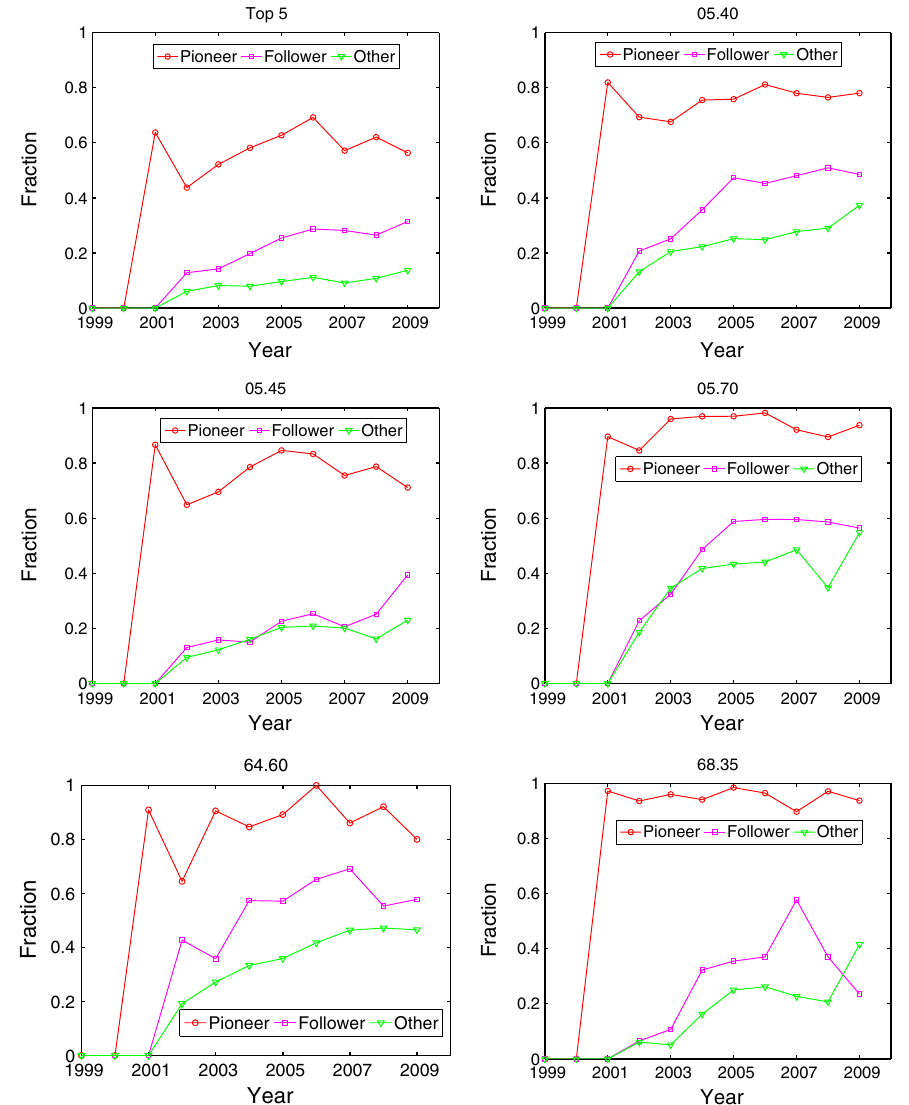
FIG. 6. Comparison of the fraction of papers published by pioneers, followers, and followers of followers. Followers are the scientists who cited at least one paper of the pioneers between 1997 and 2001 and are not the cooperators of pioneers. For a given PACS number, as indicated in the figures, we record the number of papers published in the PACS number and the number of papers published only in 89.75 ( “ Complex Networks ” ) for each author. Then, we get the total number of papers published in complex networks N number of papers with these two PACS numbers N for every author. The vertical axis shows the fraction ð N all time, which approximately satisfies pioneers > followers > the rest. This result suggests that influence links are important for cascading